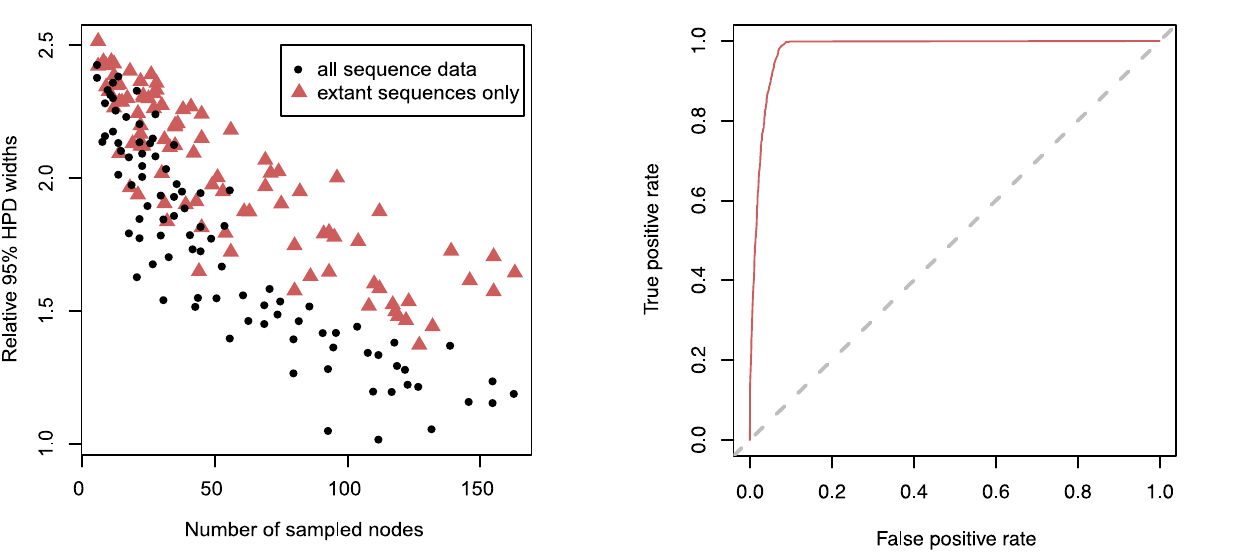
Figure 6. ROC curve for identifying sampled ancestors based on simulated data (transmission process). The posterior distribu- tion of trees obtained from a Bayesian MCMC analysis of simulated sequence data can be used to detect sampled ancestors. We identify a node as being a sampled ancestor if the posterior probability that the node is a sampled ancestor is greater than some threshold. The curve is parameterised by the threshold and shows the trade-off between true positive rate (sensitivity) and false positive rate (specificity) for different values of the threshold (any increase in sensitivity will be accompanied by a decrease in specificity). The dashed diagonal line corresponds to a ‘random guess’ test. The closer the ROC curve to the upper-left boarder of the ROC space (the whole area of the graph), the more accurate the test. The optimal value of the threshold for this curve is 0.45.